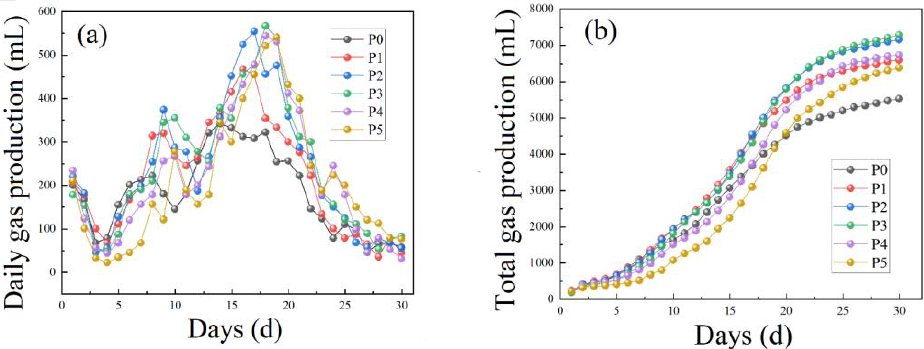
Figure 2. ( a ) Daily gas production and ( b ) total gas production of THE mixed anaerobic digestion of pig manure and straw in different proportions.